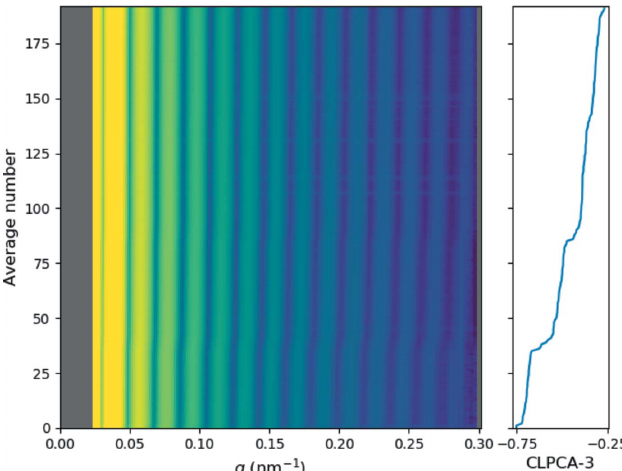
Figure 10 Correlation of radial intensity distribution with the CLPCA-3 component for the spherical 2D averages. The left-hand panel shows radial intensities versus q for 192 2D class averages. The right-hand panel shows the corresponding CLPCA-3 values. One can observe the stretching of the intensity distributions for higher values of